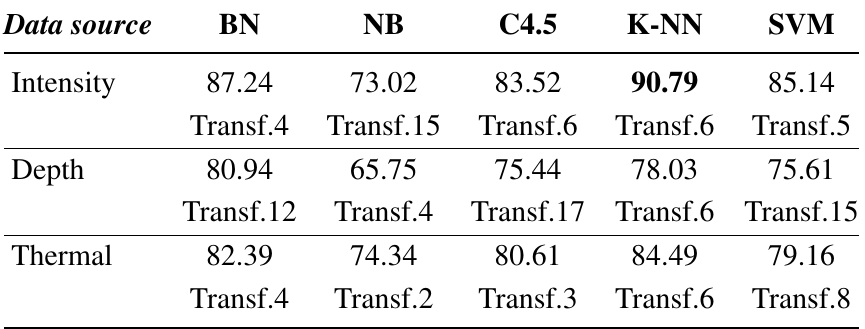
Table 7. EUREKA!: best 10-fold cross-validation accuracy percentage obtained for each classifier using transformed images. The corresponding transformation is